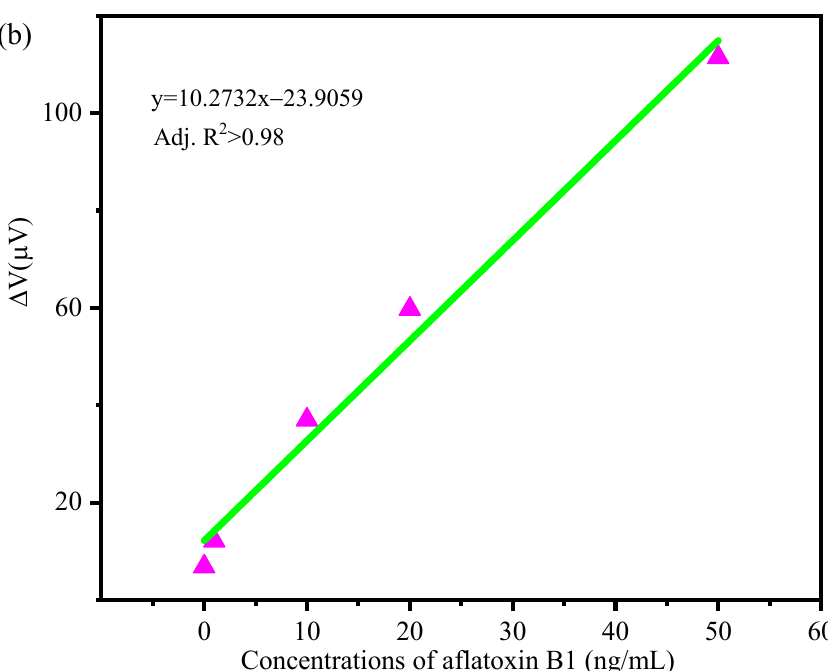
Figure 9. ( a ) the measurement results of aflatoxin B1 at concentrations of 1, 10, 20, 50 ng/mL, respectively. ( b ) a linear correlation of the measured output voltage response and aflatoxin B1 concentrations. Fitting function is y = 10.2732x − 23.9059. R 2 > 0.98 for fitting curves.